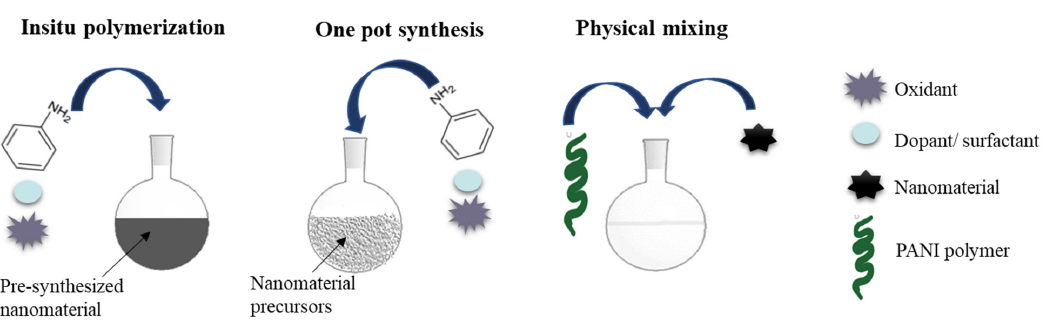
Figure 5. Schematic illustration of different methods for the synthesis of PANI